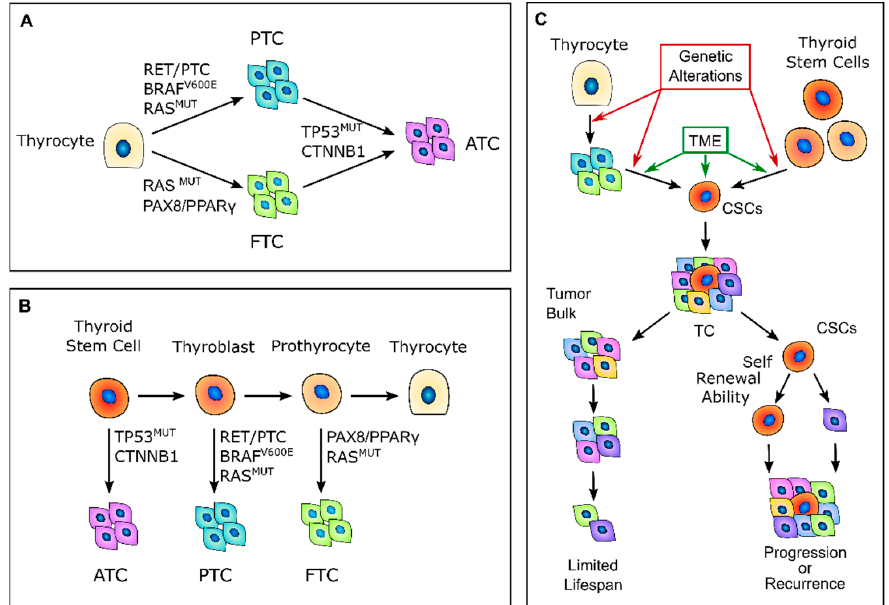
Figure 1. Thyroid carcinogenesis models. ( A ) Description of the classic multistep carcinogenesis model: the gradual accumulation of genetic alterations in normal thyrocytes leads to the transforma- tion into cancer cells and to the acquisition of subsequently less differentiated and more aggressive phenotypes. Mutations in driver genes, such as BRAF and RAS or RET/PTC and PAX8/PPAR γ rear- rangements, give rise to the well-differentiated papillary thyroid cancers (PTCs) and follicular thyroid cancers (FTCs), while the acquisition of TP53 and CTNNB1 mutations leads to the transformation in anaplastic thyroid cancers (ATCs). ( B ) Fetal stem cells’ origin model: thyroid cancer cells are derived from normal stem cells or precursor cells of fetal origin that acquire transforming mutations. These genetic alterations confer proliferative advantages and prevent fetal thyroid cells from differentiat- ing. Less differentiated stem cells give rise to ATCs, while the more differentiated thyroblasts and prothyrocytes give rise to PTCs and FTCs, respectively. ( C ) Cancer stem-like cells’ (CSCs) origin model: CSCs with high tumorigenic activity and increased ability to self-renew originate from either normal stem cells through a transformation process or from differentiated cancer cells as the result of a dedifferentiation process. The transition of stem cells into mature cancer cells is stimulated by the different tumor environment that is present outside the stem niches. Mature cells cannot sustain tumor progression, while CSCs can reconstitute and sustain tumor growth. TME, tumor microenvironment; TC, thyroid